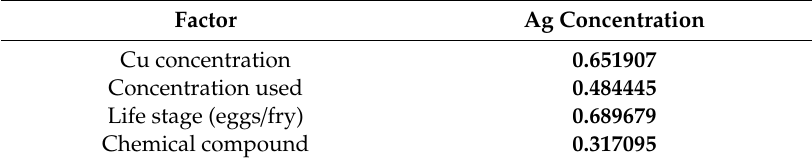
Figure 2. Mean and standard deviation of Ag concentrations in the rainbow trout groups after the Ag applications, depending on the life stage (eggs or fry), chemical compound (0 (control), AgNPs, AgNO 3 ), and Ag concentration (0, 1, 2, 4, 8, 16 mg/L). Different letters indicate statistical differences ( p < 0.05) between groups. Table 4. Spearman correlation results. The statistically significant correlations are marked in bold ( p < 0.05). Factor